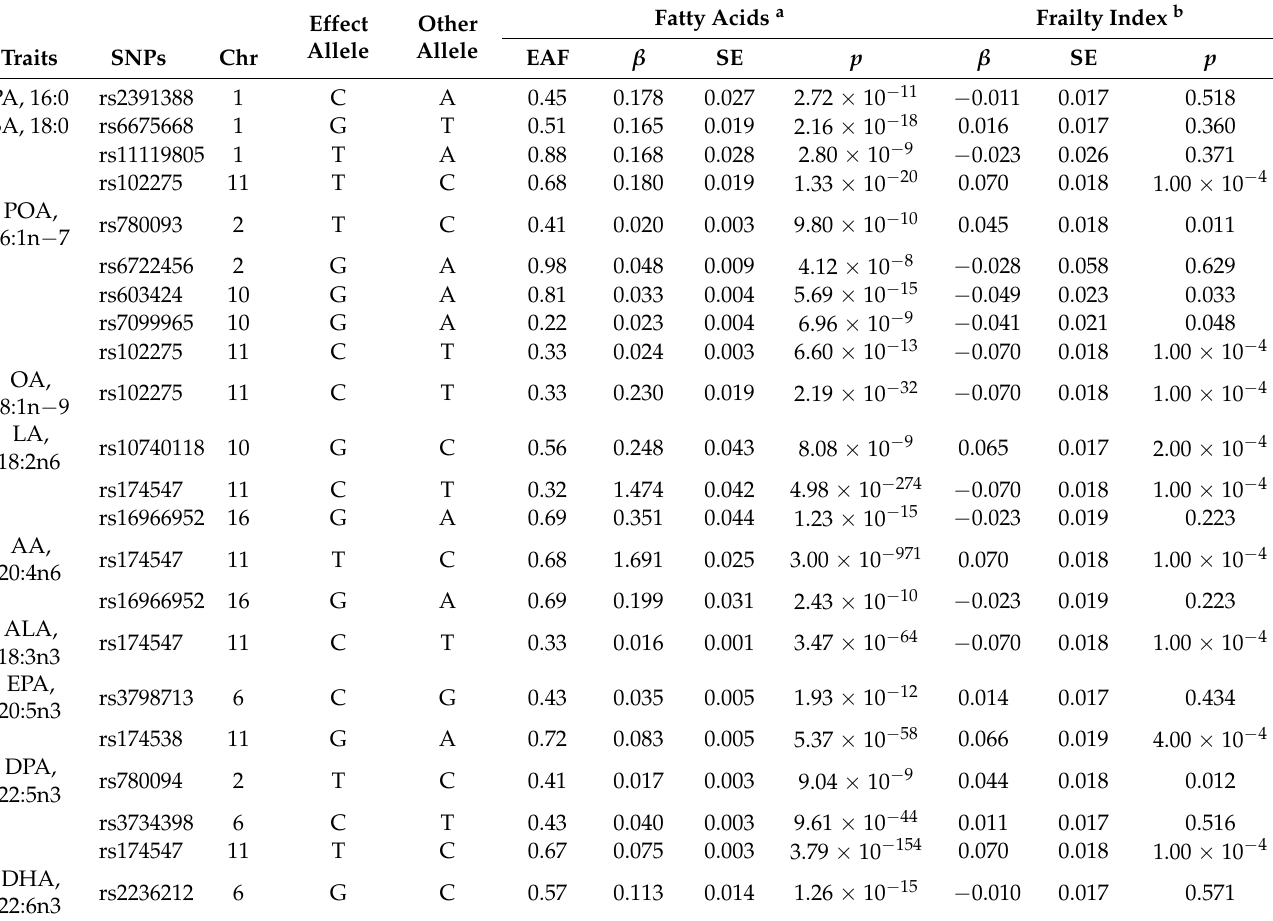
Table 1. Summary statistics of fatty acids-raising genetic